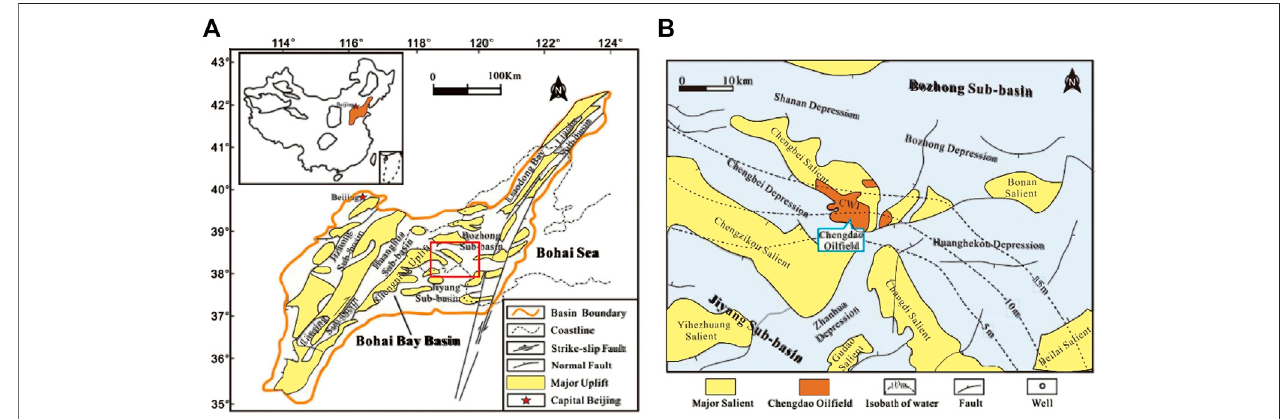
FIGURE 1 | Location of the study area. (A) Location and tectonic divisions of the Bohai Bay Basin. The red box highlights the location of our study area. (B) Structural features of the central Bohai Bay Basin and the location of the Chengdao Oil fi eld (modi fi ed from Li et al., 2019).